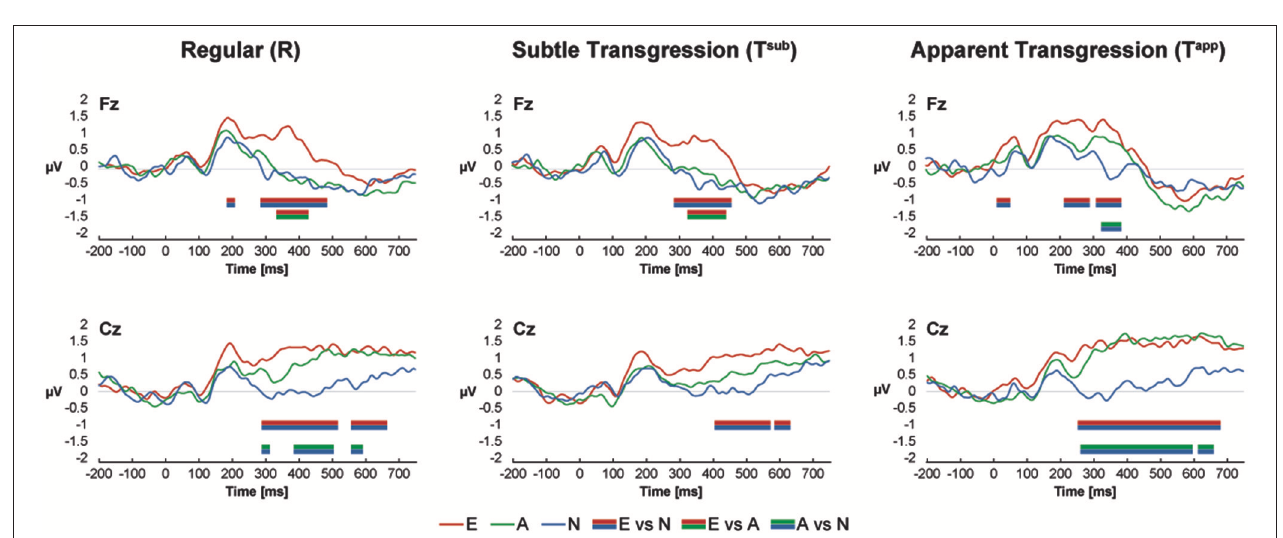
FIGURE 3 | ERP Results at Fz and Cz. Color-coded bars (see legend at the bottom of the graphs) indicate Bonferroni corrected contrasts between the Expertise groups for each Transgression Condition, with a minimum time constraint of 28 consecutive